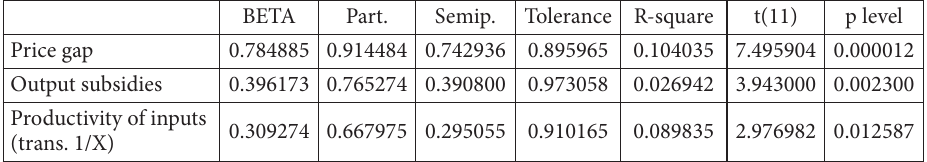
Table 9. Partial and semi-partial correlations for variables from Eq. (5)